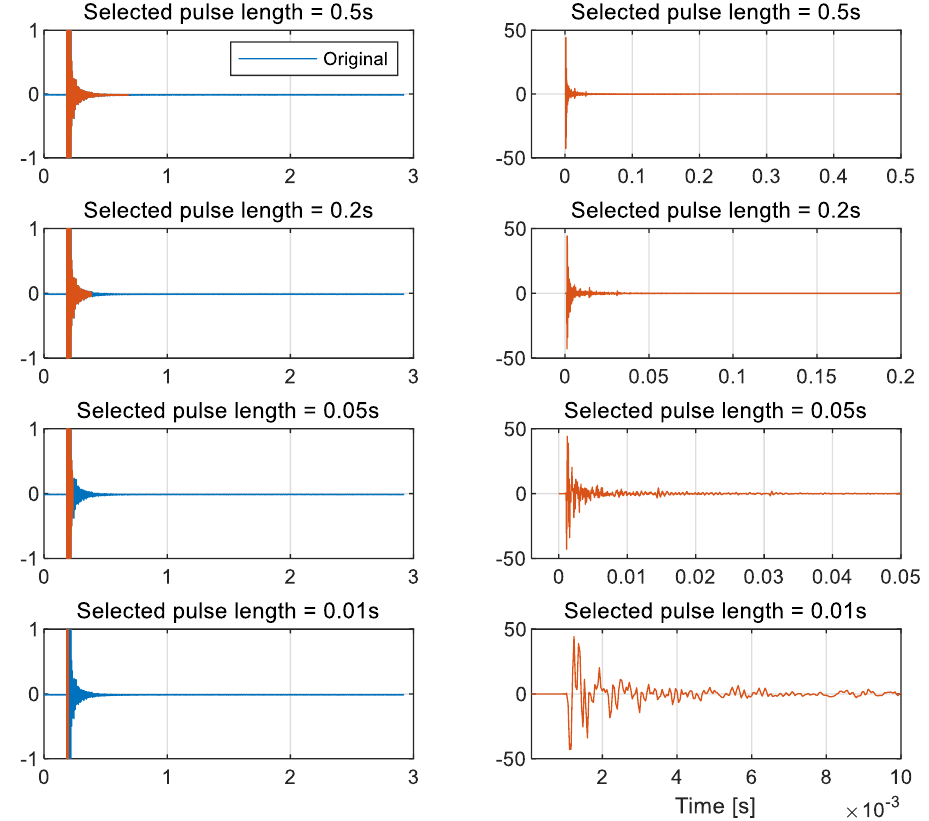
Figure 5. Pulse with different duration. Left : Y-zoom of selected pulse plotted with full-length pulse as reference, right : selected pulse in full scale (note: variable time scale).